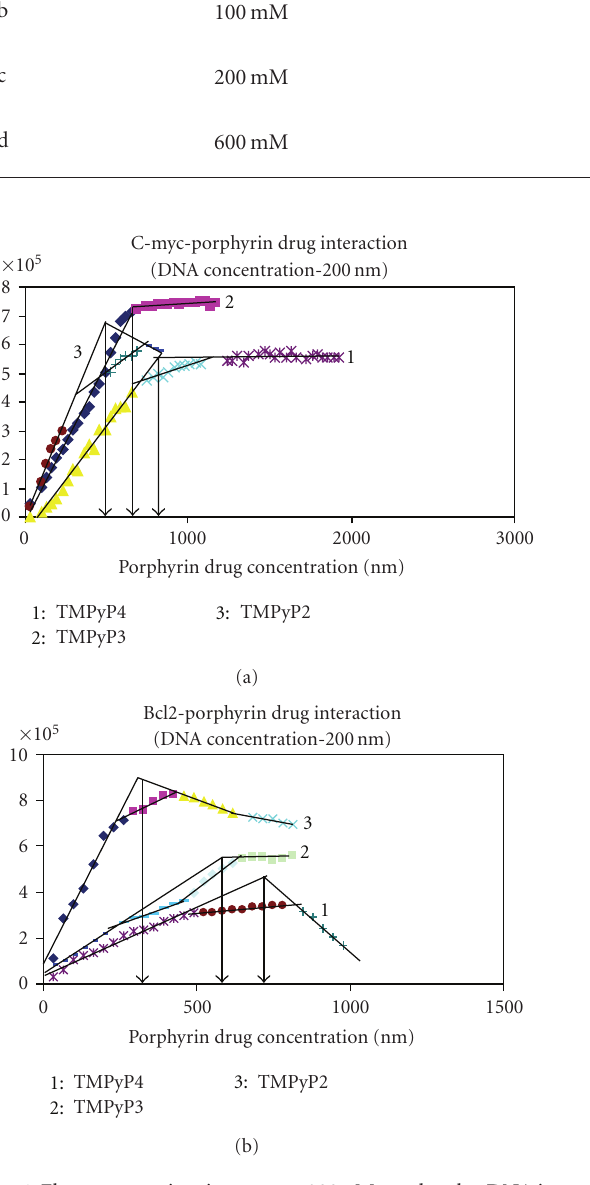
Figure 4: Fluorescence titration curves. 200 nM quadruplex DNA is titrated with 0–1200 nm concentration of three di ff erent porphyrin drugs. Stoichiometry is considered at saturation levels. Hence the slop of initial and end points are considered.1: TMPyP4, 2: TMPyP3, and 3: